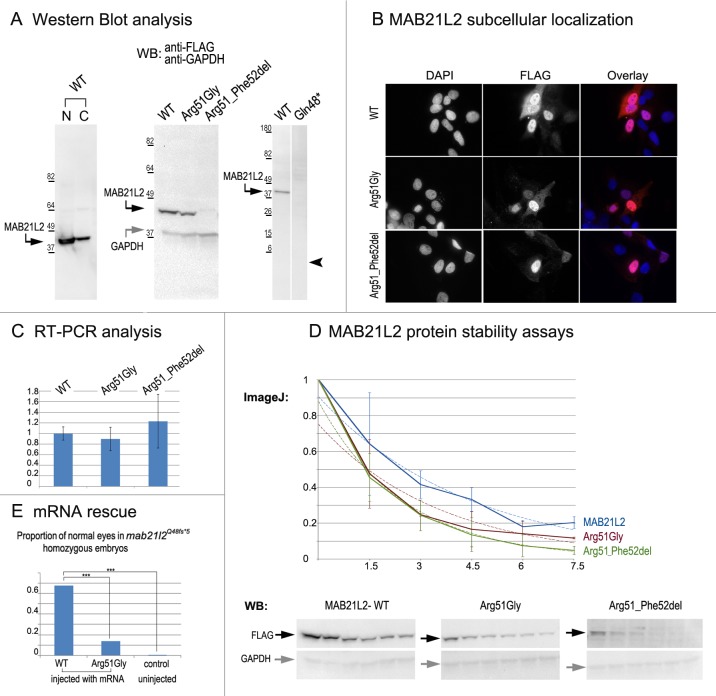
MAB21L2 wild-type and mutant protein studies.
A. Western Blot analyses of MAB21L2 wild-type and mutant proteins (with N-terminal FLAG tag) in HLE-B3 cells. Please note the presence of wild-type MAB21L2 in both nuclear (N) and cytoplasmic (C) fractions (left), decreased expression of Arg51Gly and Arg51_Phe52del mutants (center) and the absence of Gln48* mutant protein (right; arrowhead indicates region corresponding to 5.5kDa, the predicted molecular weight for this peptide); predicted molecular weight for MAB21L2 is ~41kDa and for GAPDH is ~36 kDa; positions and corresponding molecular weights of protein ladder are shown for every blot. B. Cellular immunofluorescence analysis demonstrated no significant alteration in the localization pattern between wild-type and mutant (Arg51Gly and Arg51_52del) proteins with predominant nuclear localization and some cytoplasmic staining for all forms. C. RT-PCR analysis of MAB21L2 wild-type and mutant transcripts in human lens epithelial cells transfected with corresponding expression constructs. D. Protein stability assays with cycloheximide showed a more rapid decrease in the amount of Arg51Gly and Arg51_Phe52del mutant proteins in comparison to wild-type protein. Western blots signals were measured using ImageJ software, and obtained values were graphed to produce degradation curves represented by solid blue (wild-type), red (Arg51Gly) and green (Arg51_Phe52del) lines (standard deviations for every time point are indicated as thin vertical lines and exponential decay curves fitted into each graph are shown as dotted lines of corresponding colors); representative Western blot (WB) images are shown on the bottom (stability assays were performed in triplicate; 0, 1.5, 3, 4.5, 6, and 7.5 correspond to hours of exposure to cycloheximide). E. Summary of mRNA rescue experiments. Proportions of embryos with normal eyes in homozygous mab21l2Q48fs*5 embryos injected with wild-type human MAB21L2 mRNA, mRNA encoding the p.(Arg51Gly) mutant protein, and uninjected control larvae are shown; statistically significant (p<0.0005) differences are indicated with asterisks (***).